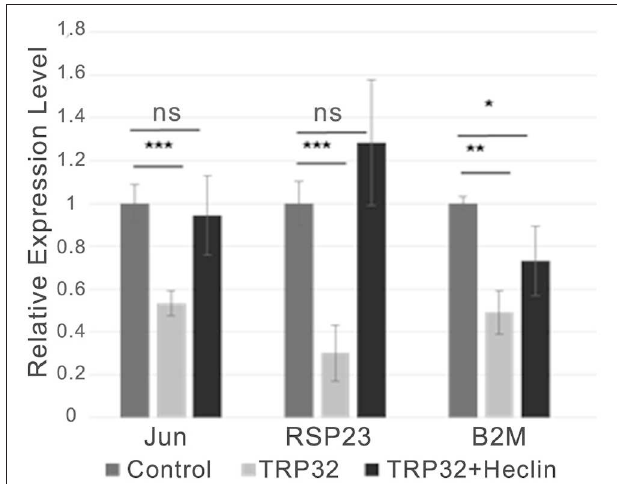
FIGURE 5 | TRP32-mediated transcriptional repression is alleviated by the HECT E3 Ub ligase inhibitor heclin. GFP-TRP32 or a GFP control were transfected into HeLa cells with TRP32-target promoter firefly luciferase expression constructs and Renilla luciferase expression vectors in the presence of the HECT E3 Ub ligase inhibitor heclin or vehicle. After 24h luciferase expression was measured and normalized to constitutive Renilla luciferase expression and is presented as fold-change from control. Significance was determined using a Student’s t -test (* p ≤ 0.05, ** p ≤ 0.01, *** p ≤ 0.001). Graph is representative of at least three